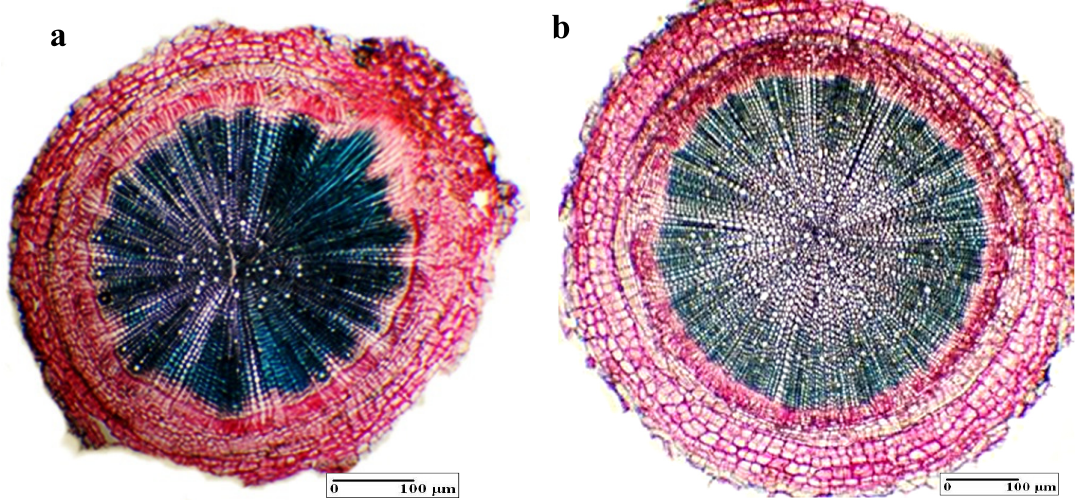
Figure 4. The internal structure of the main root: ( a ) general aspect (control), ( b ) general aspect (BBPE 1—central cylinder, cortex, and rhizodermis).